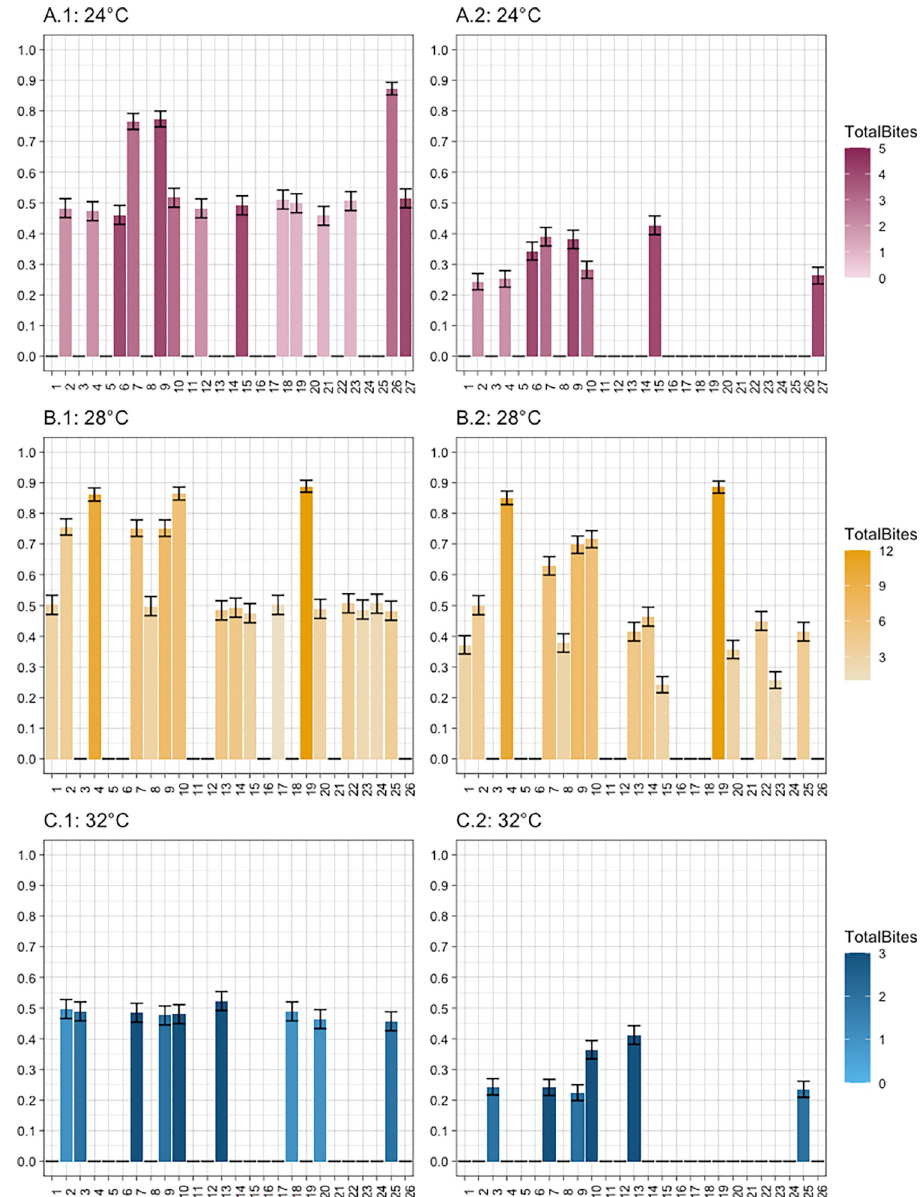
Fig 2. The proportion of mosquito–specific simulations (y–axes) that resulted in successful mosquito exposure from the index case (A–C.1) and subsequent transmission to the susceptible human (A–C.2) at each temperature: 24˚C (A), 28˚C (B), and 32˚C (C). Color gradients indicate total number of bites per individual that transmitted. Correlation of biting profile with simulated transmission potential The correlation between mosquito exposure and subsequent transmission was uniformly posi- tive, and moderate to high (0.6 at 24˚C, 0.90 at 28˚C, and 0.73 at 32˚C). The total number of bites was highly and significantly correlated with mosquito exposure and subsequent transmis- sion across all temperatures ( Table 3 ). Time-to-first bite (TTFB) was also significantly corre- lated with mosquito exposure across all temperatures but was not significantly correlated at 32˚C for transmission to a susceptible human ( Table 3, Fig J in S1 Text ). These relationships